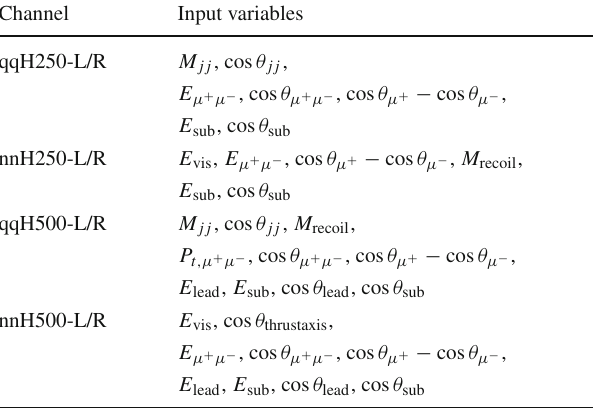
Table 8 Input variables to the BDTG for each channel. These variables are defined in the text